Question: What kind of plot is shown here?
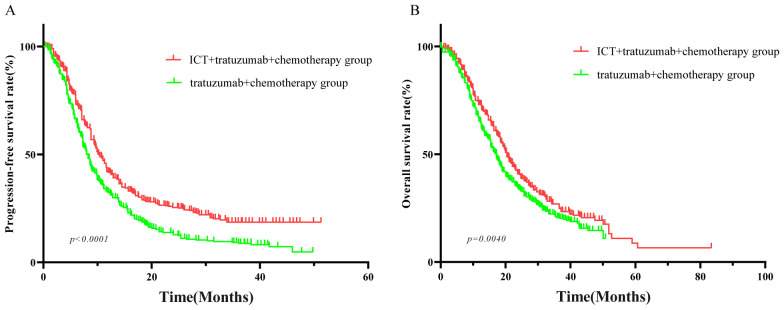
Answer: survival